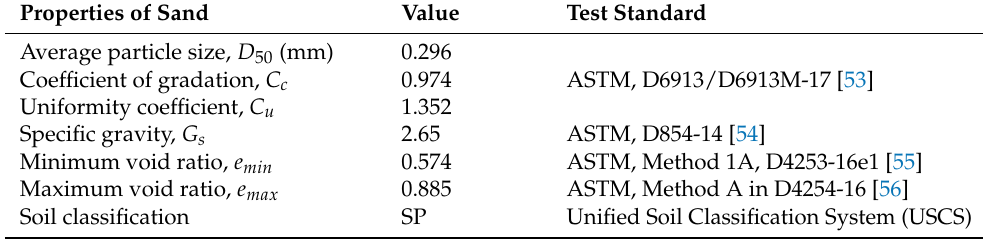
Table 1. The index properties of Sile sand.